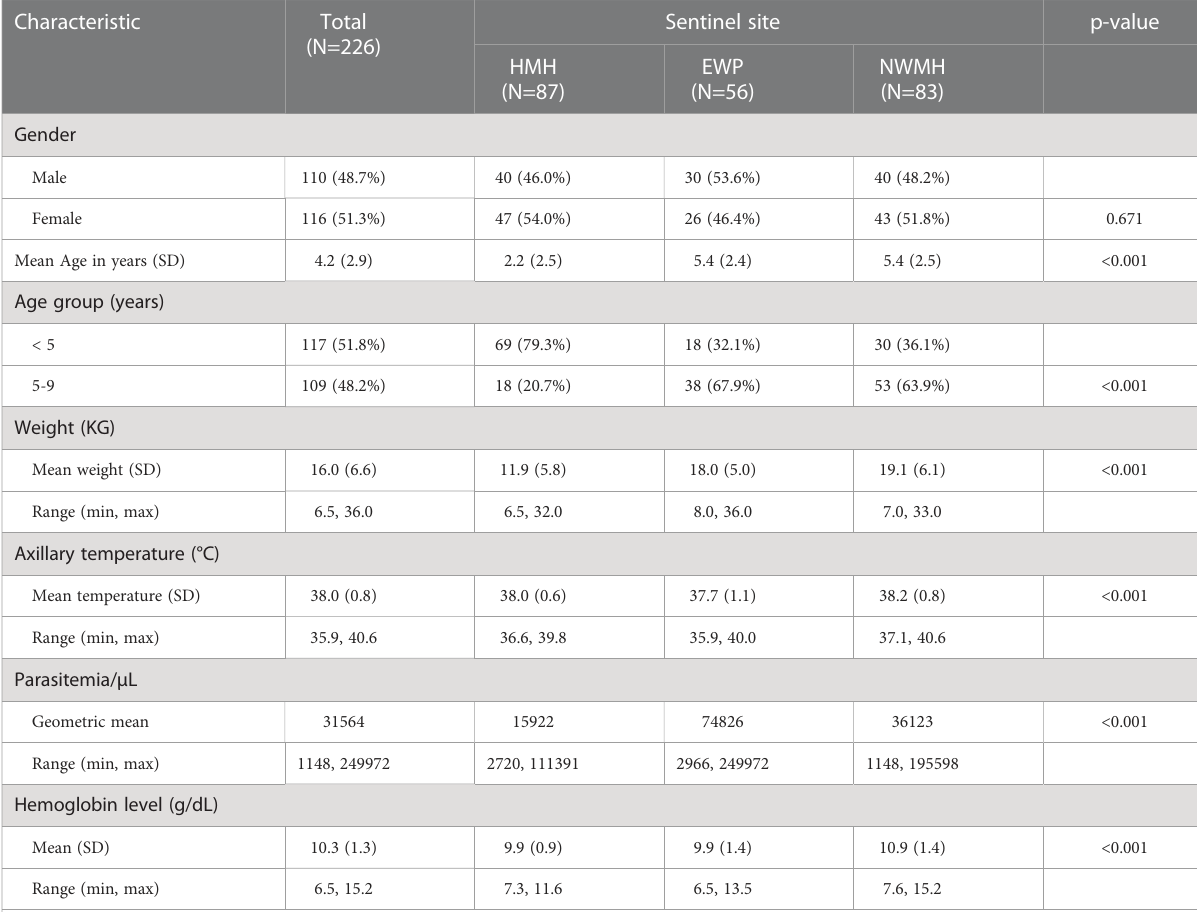
TABLE 2 Background characteristics of patients enrolled.